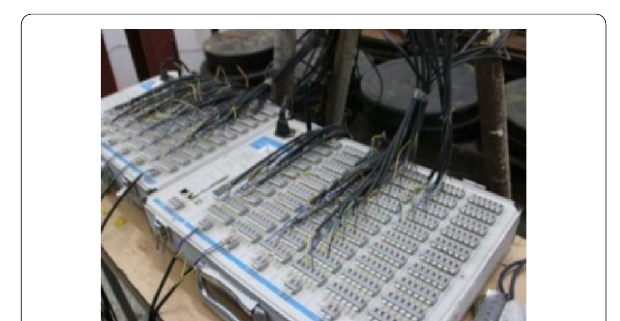
Fig. 4 Static strain acquisition